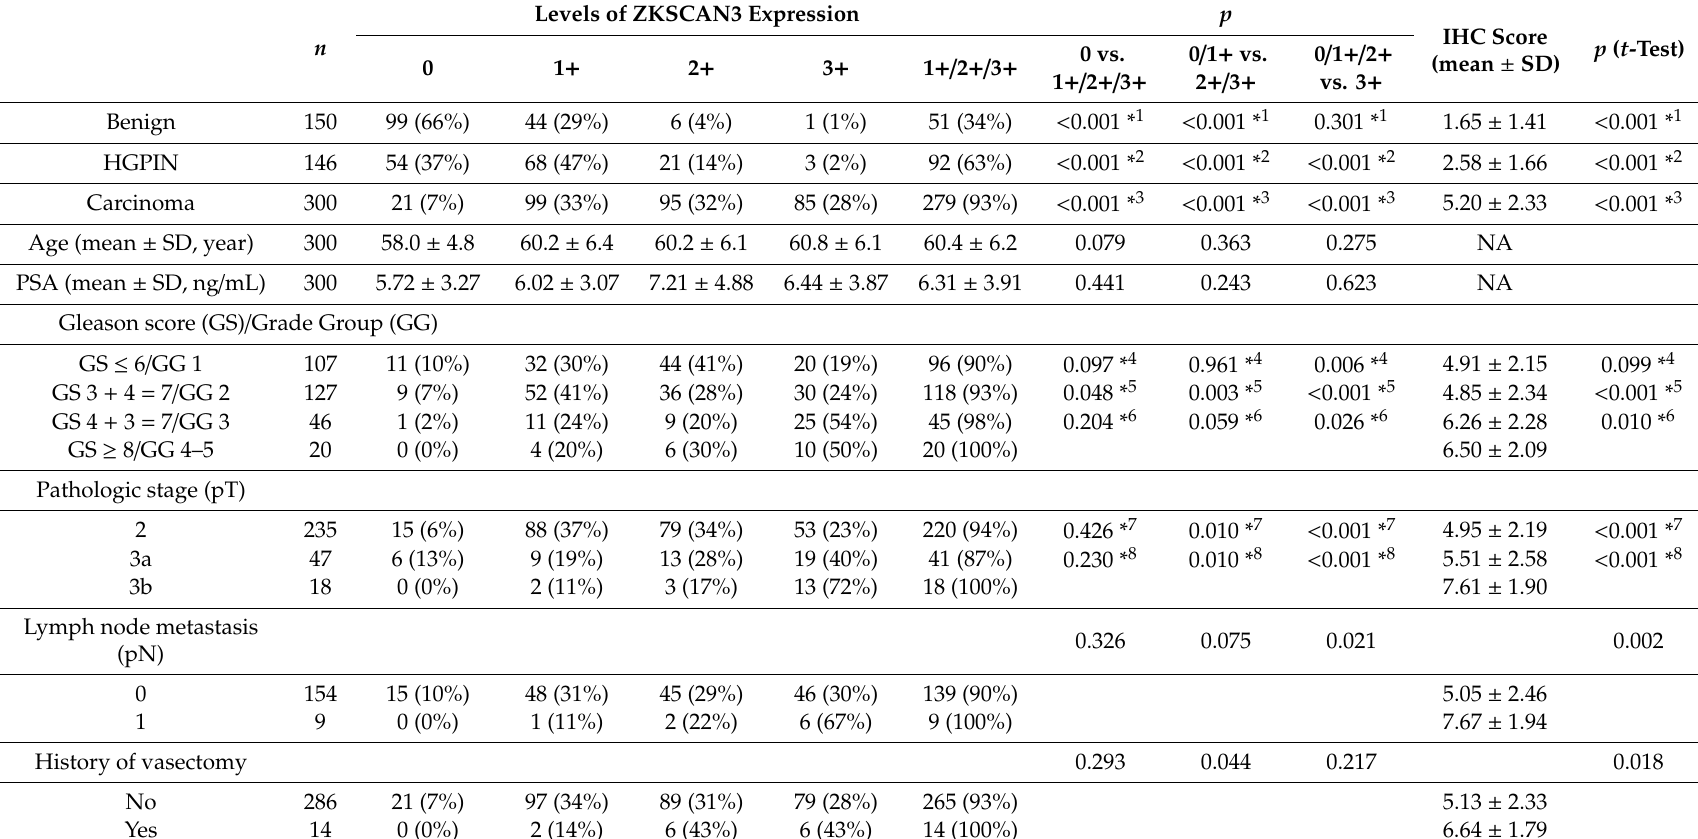
Table 2. Expression levels of ZKSCAN3 in radical prostatectomy